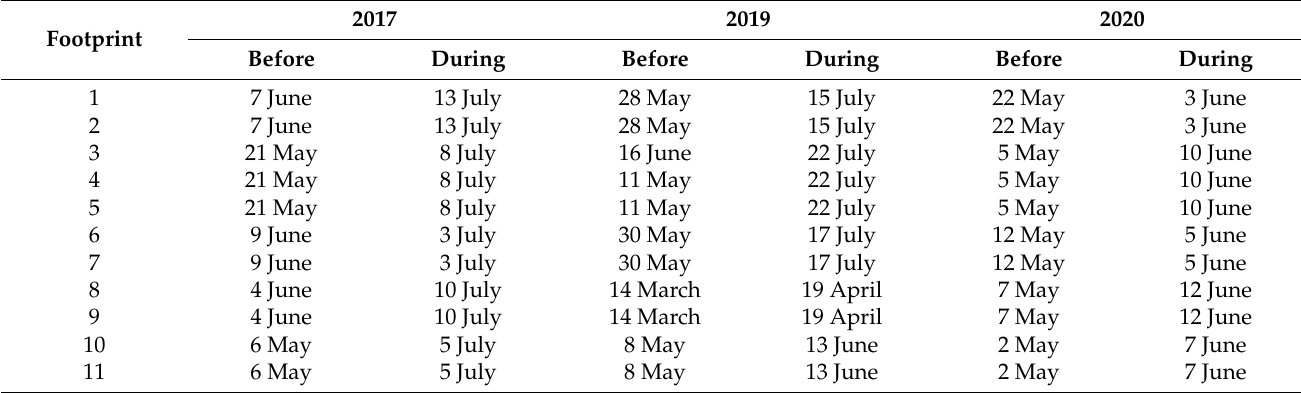
Table 1. Sensing dates of Sentinel-1 images in different footprints in Figure 2 (before and during floods).